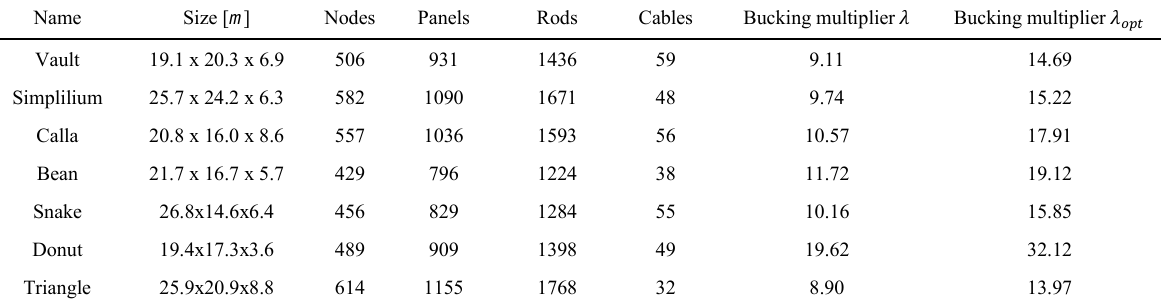
Table 1: Metrics and analysis results on different models with reference to Fig.